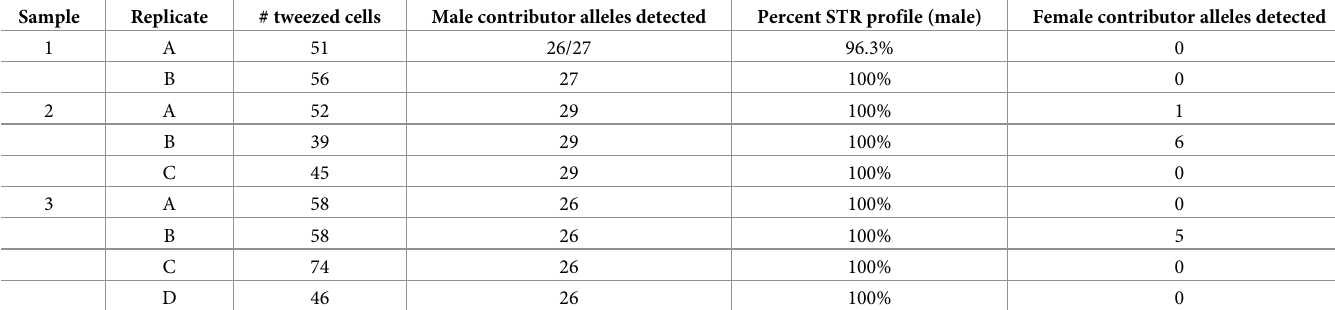
Table 2. STR results from optical tweezer-separated spermatozoa fractions from mixed vaginal:Sperm